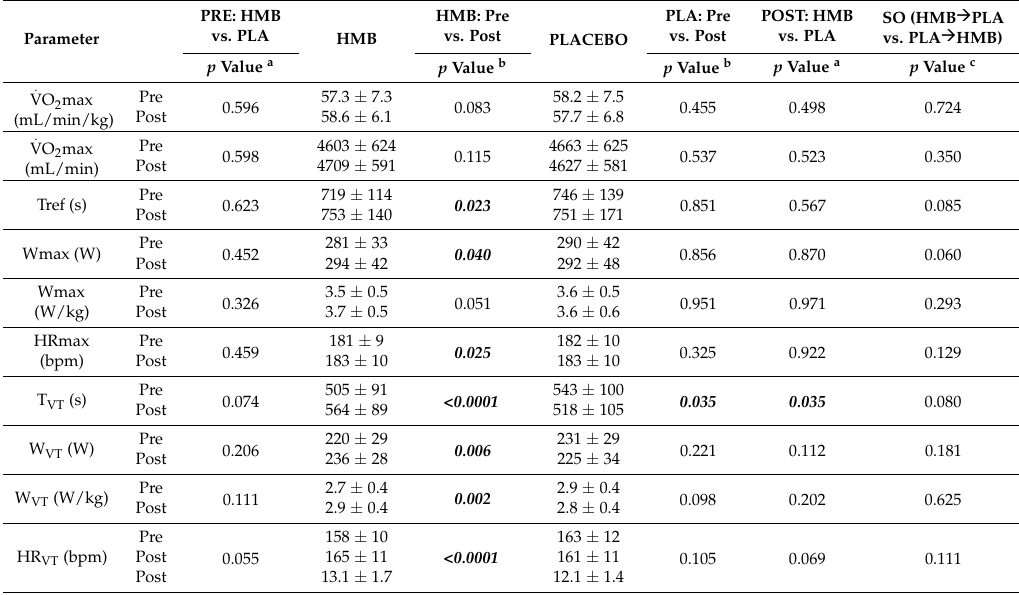
Table 3. Levels of the monitored aerobic capacity indices before and after the 12-week supplementation with HMB and placebo preparation.